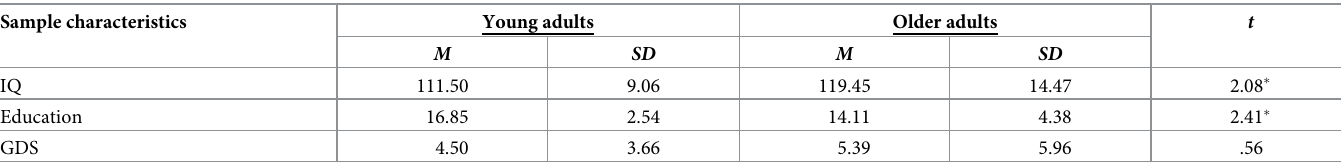
Table 2. Group depression, IQ and education